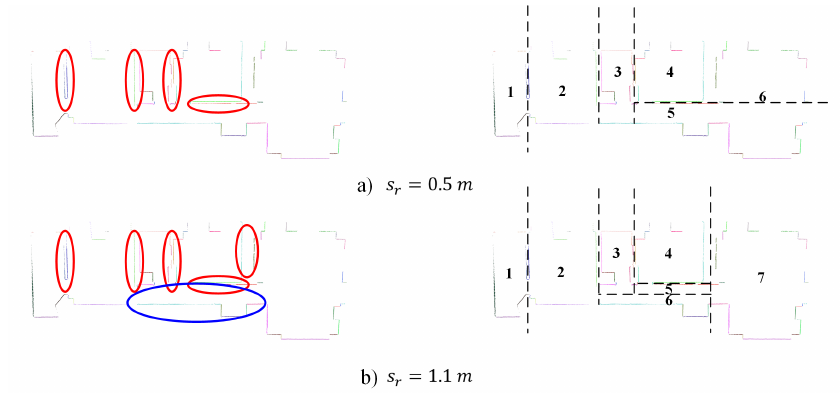
Figure 22. The experimental results for different values of search radius s r : ( a ) Under-partition, and ( b ) over-partition. Red circle: Detected parallel structures; Blue circle: Over-partition situation; Dashed line: Partition boundaries.